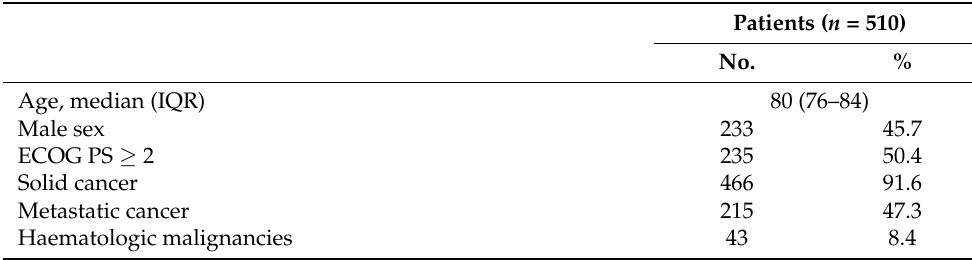
Table 1. Main characteristics of the 510 patients